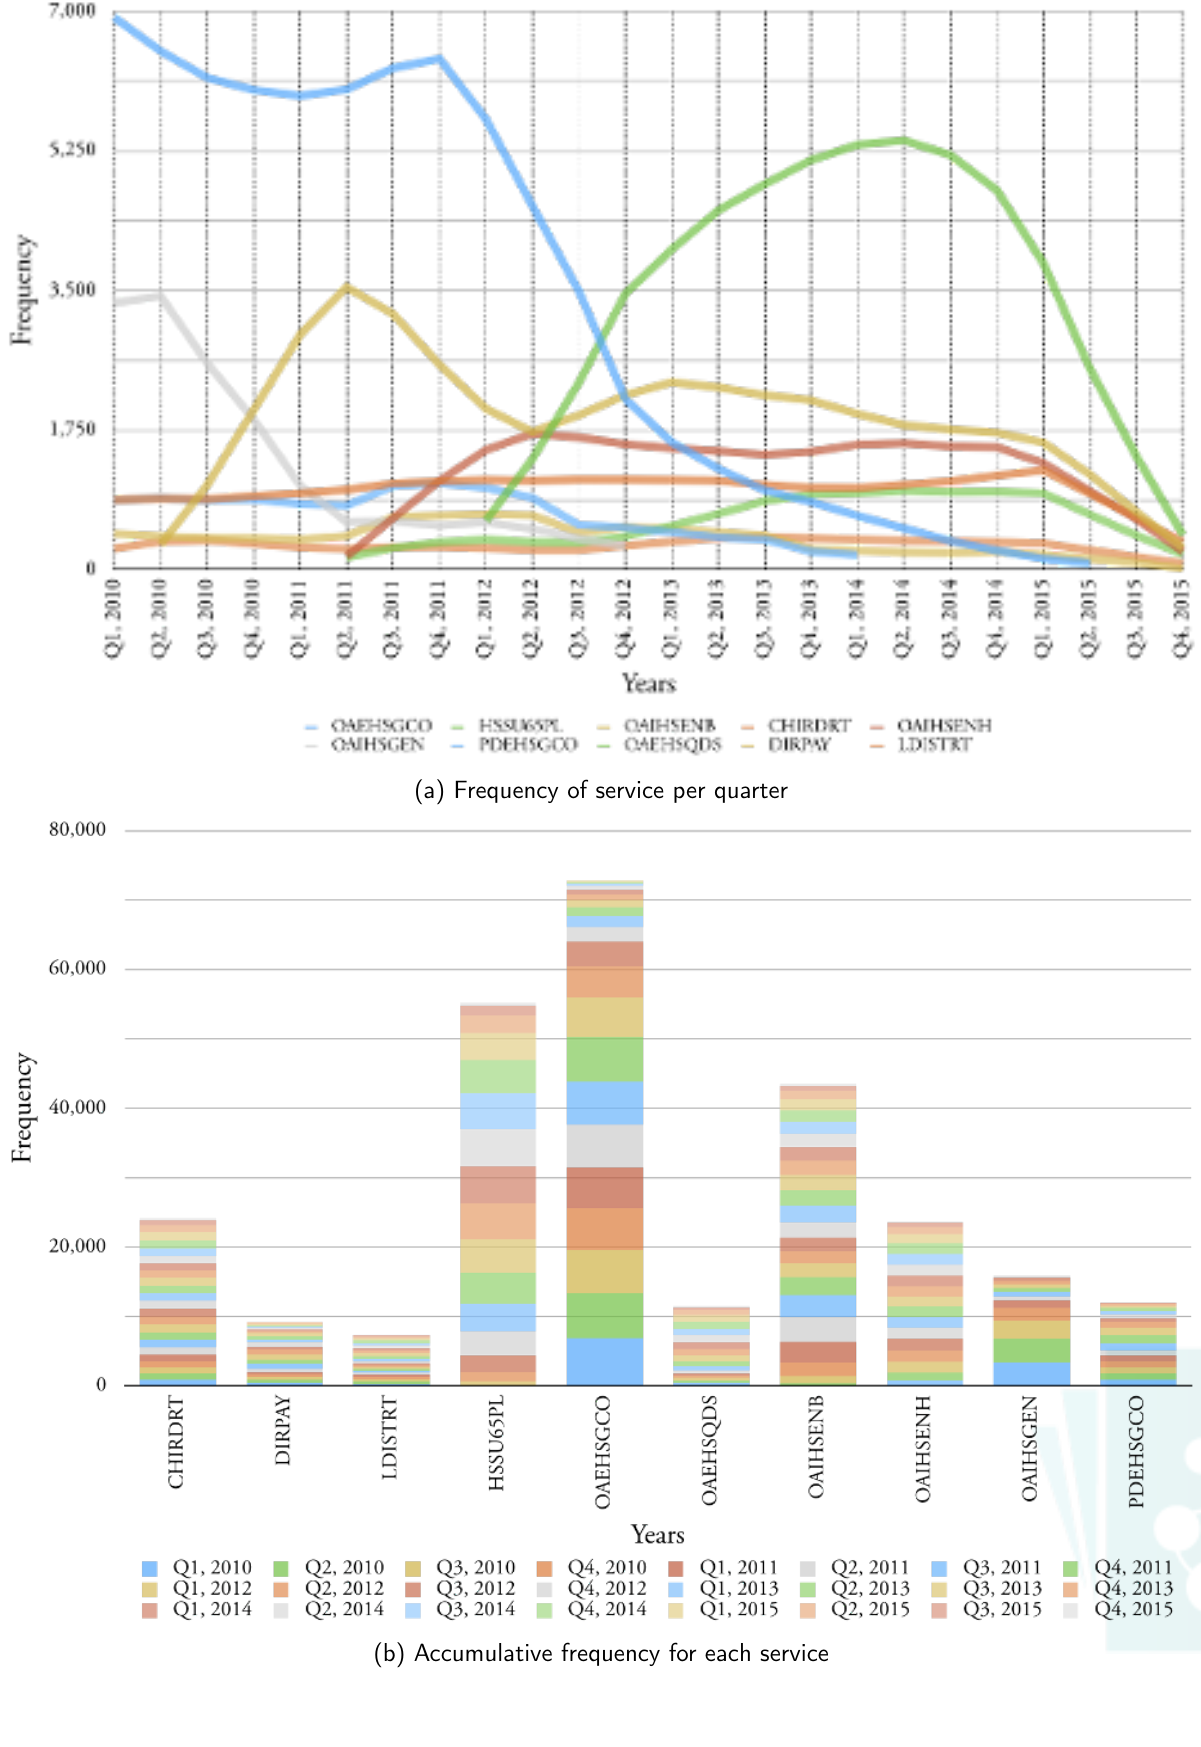
Figure 4: Top ten service elements in terms of commissioning frequency, for all age categories for the period